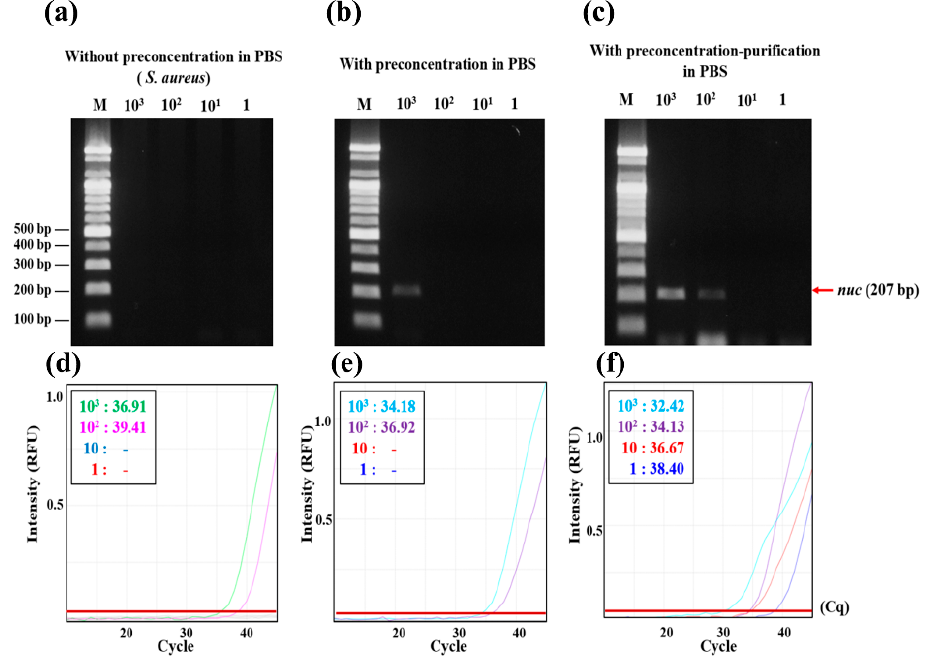
Figure 5. Confirmation of Staphylococcus aureus preconcentrating and DNA purifying efficiency using PCR with gel electrophoresis and qPCR; ( a ) Gel electrophoresis of PCR products ( nuc gene) from 10 mL PBS containing S. aureus at different concentrations (1–10 3 CFU/mL) before preconcentration; ( b ) after preconcentration; ( c ) after bacterial preconcentration and DNA purification; ( d – f ) qPCR results of ( a – c ), respectively.